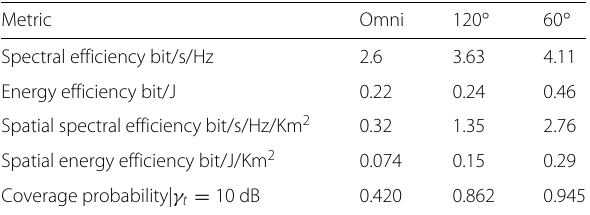
Table 2 Comparison results for fixed values of SNR=10 db, R d = 3, α = 4 and m = 4